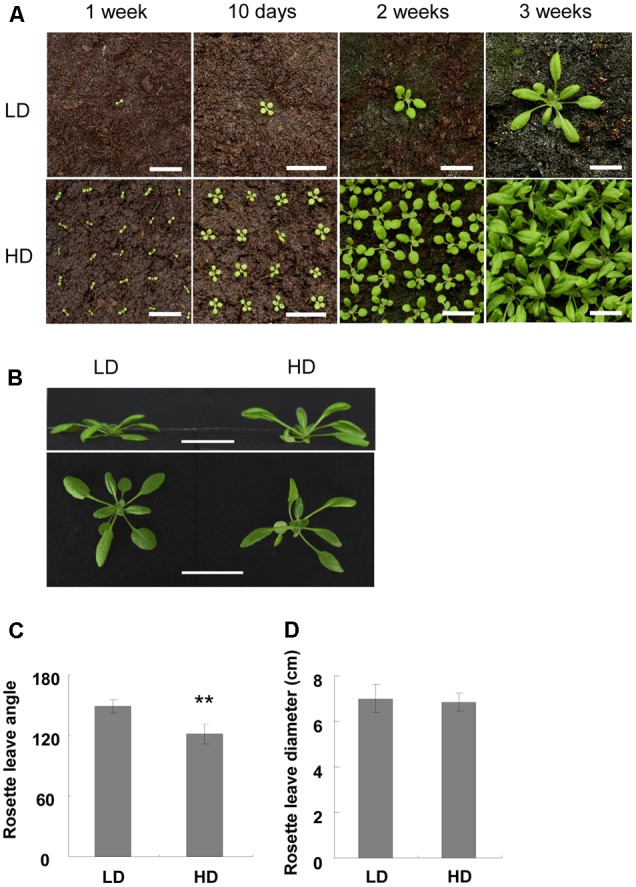
Characterization of Col-0 at high and low densities. (A) Photo of Col-0 at different stages and densities. Bars = 2 cm. (B) Side view of 3-week-old plants in different growth densities. Bars = 3 cm. (C,D) Rosette leaf angle (C) and rosette diameter (D) of 3-week-old plants. ∗∗Represents P-value < 0.01.